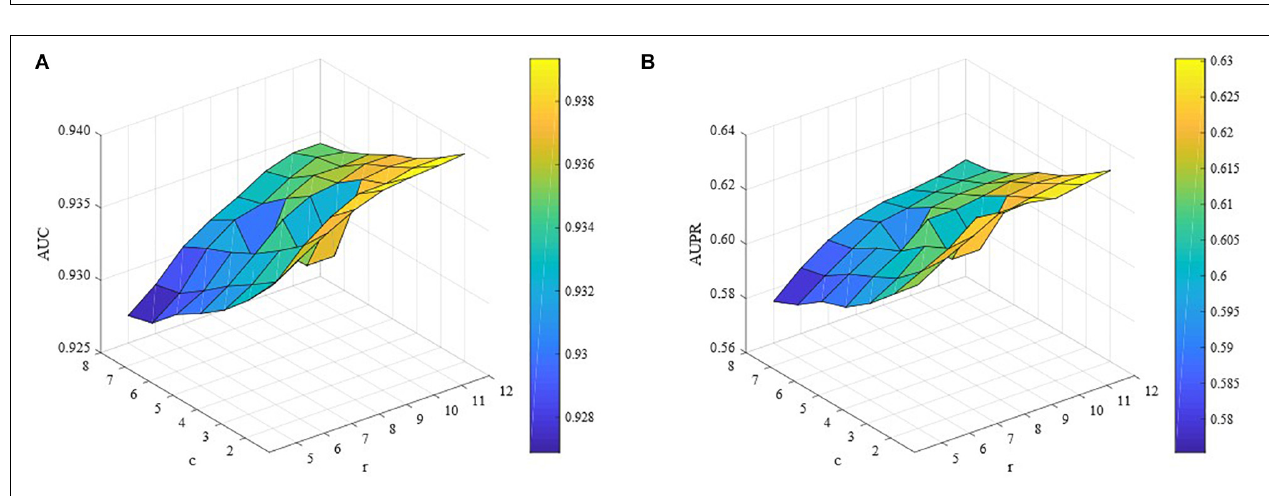
FIGURE 2 | Performance of ILMF on “DrugMetaboliteAtlas” dataset with different values of λ and φ . (A) AUC versus λ and φ ; (B) AUPR versus λ and φ .